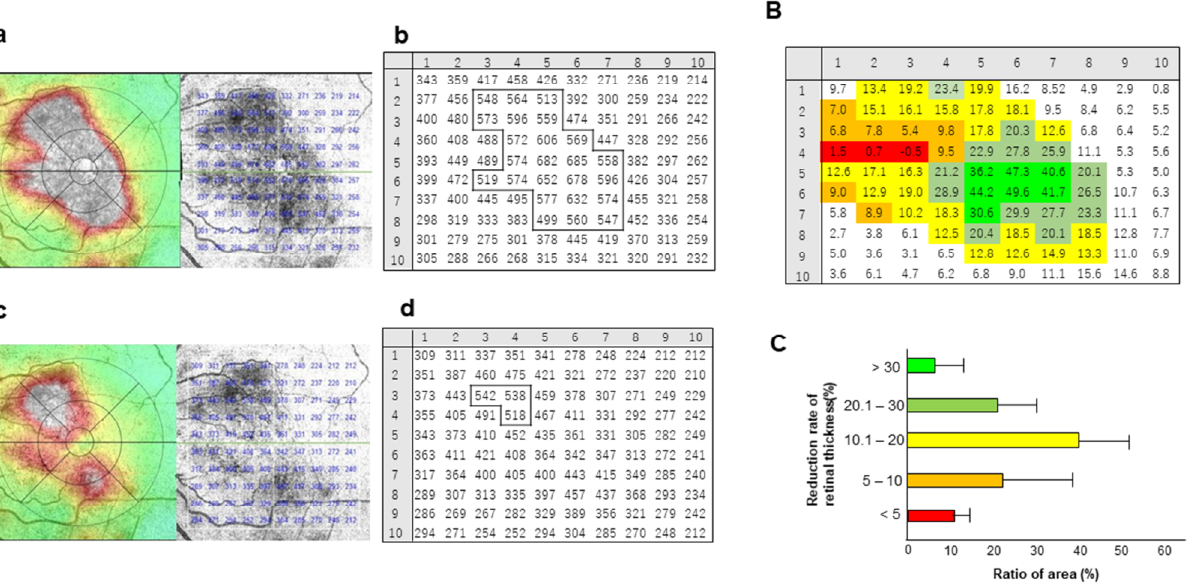
Figure 2. Distribution pattern of the reduction rate of retinal thickness. ( A ) Representative case of OCT map image and 3D-map of retinal thickness before ( a , b ) and 1 month after injection ( c , d ) of anti-VEGF agents. The macular area (6 mm × 6 mm square) was divided into 100 sections (10 × 10 squares), and the retinal thickness in each section was measured ( b , d ). Areas greater than 500 µ m in retinal thickness were outlined. OCT, optical coherence tomography. ( B ) Distribution pattern of the retinal thickness reduction rate after anti-VEGF treatment in a representative case. The light green, dark green, yellow, orange, and red colors indicate the areas where the reduction ratio was more than 30%, 20.1–30%, 10.1–20%, 5.1–10% and less than 5%, respectively. ( C ) Proportion of areas showing different retinal thickness reduction rates in all